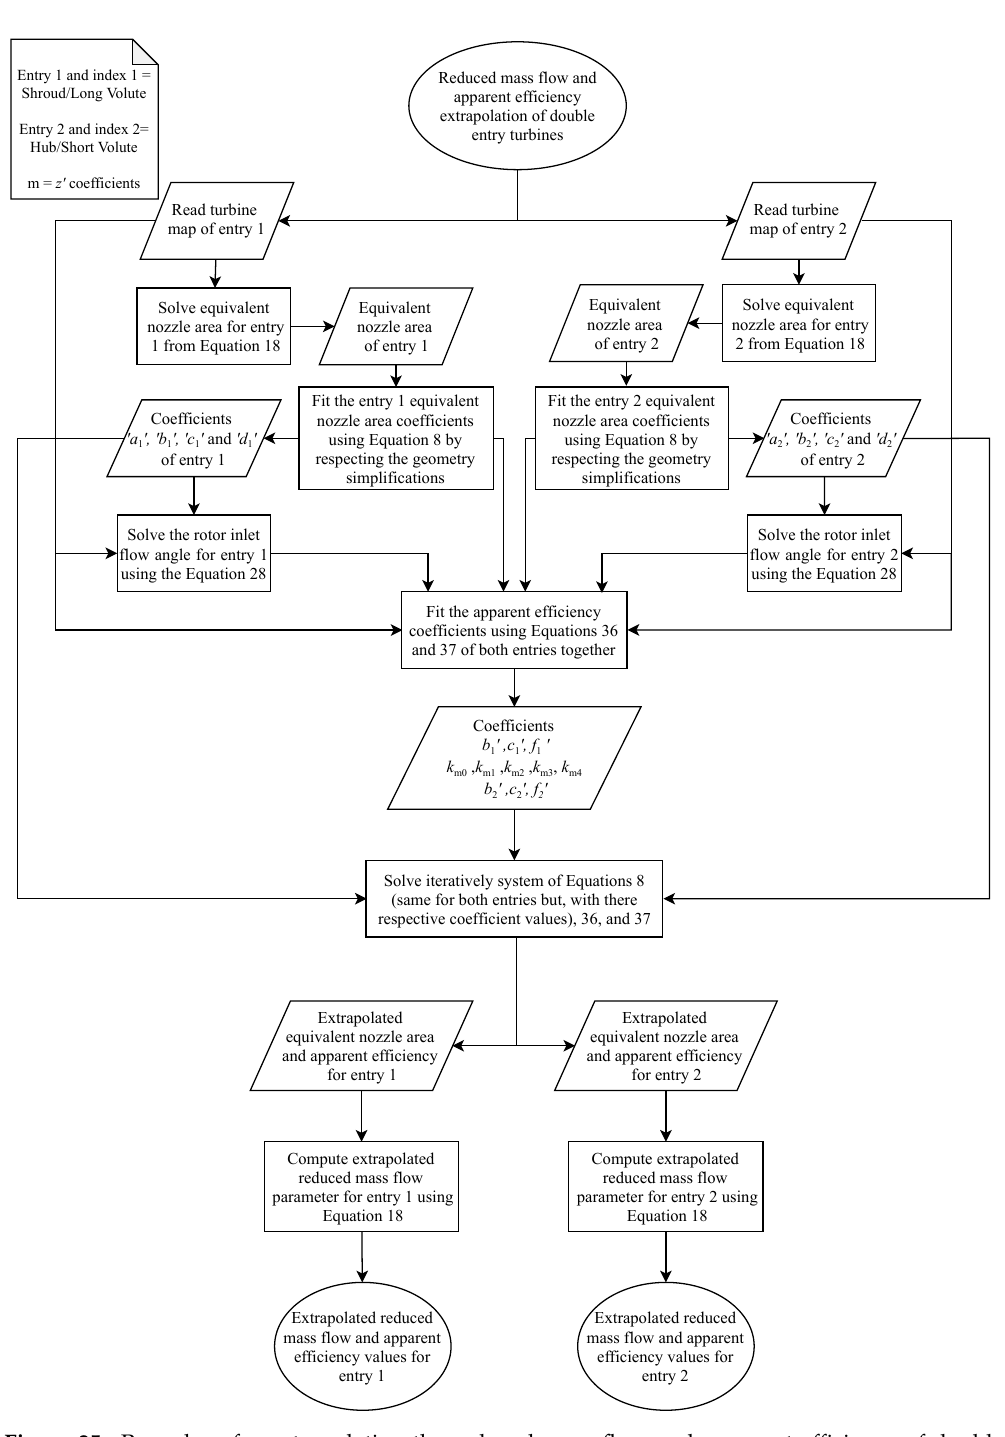
Figure 25. Procedure for extrapolating the reduced mass flow and apparent efficiency of double entry